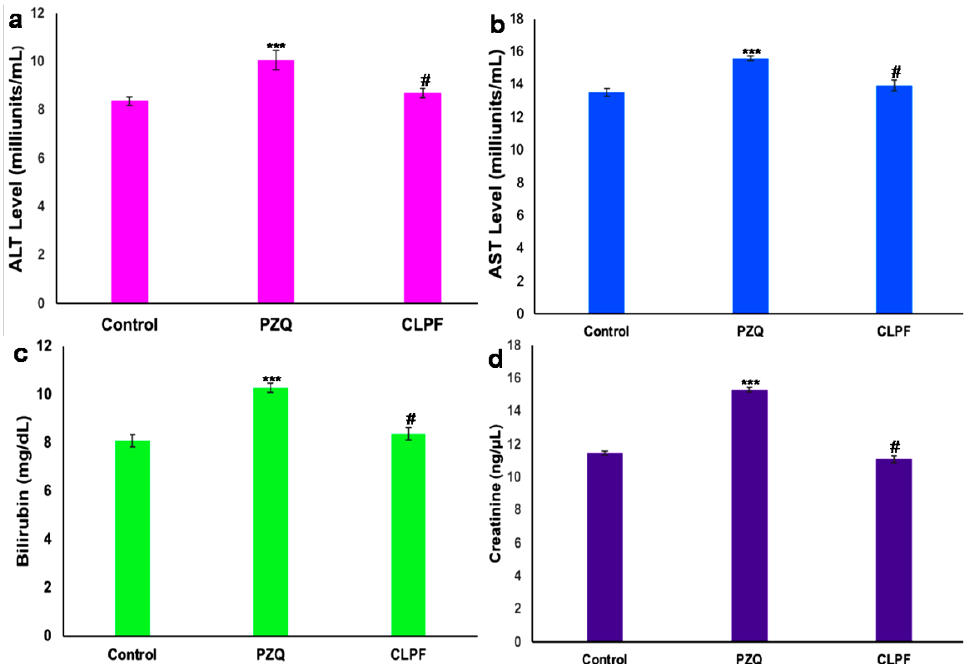
Figure 14. Biochemical markers ( a ) ALT ( b ) AST ( c ) Bilirubin and ( d ) creatinine levels in plasma. Values are expressed as mean ± standard deviation of five determinations (Data represent n = 3, mean ± SD). *** indicates p < 0.0001 when compared to the control group, and # indicates p < 0.0001 when compared to the PZQ group.